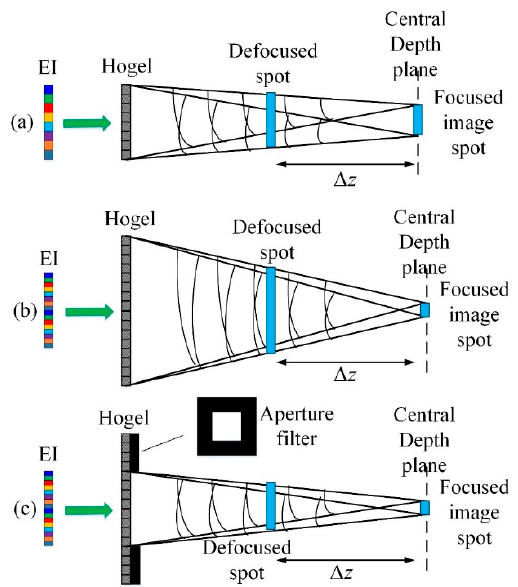
Figure 7. ( a ) A typical case in which the pixel size Δ x 1 of EI equals to the pixel size Δ x 2 of hogel. ( b ) Reduced Δ x 1 causes enlarged hogel size. ( c ) The proposed aperture filtering technique.